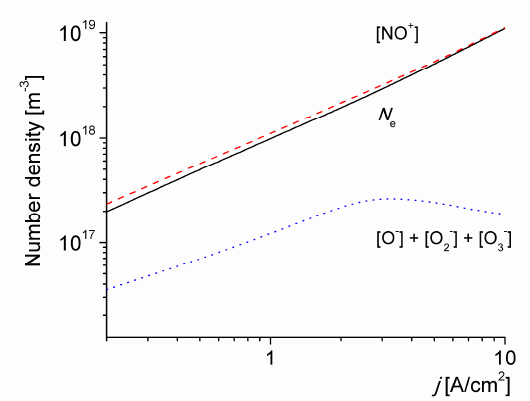
Figure 5. The number density of the charged particles in the discharge versus the discharge current density for T 0 = 1800 K.